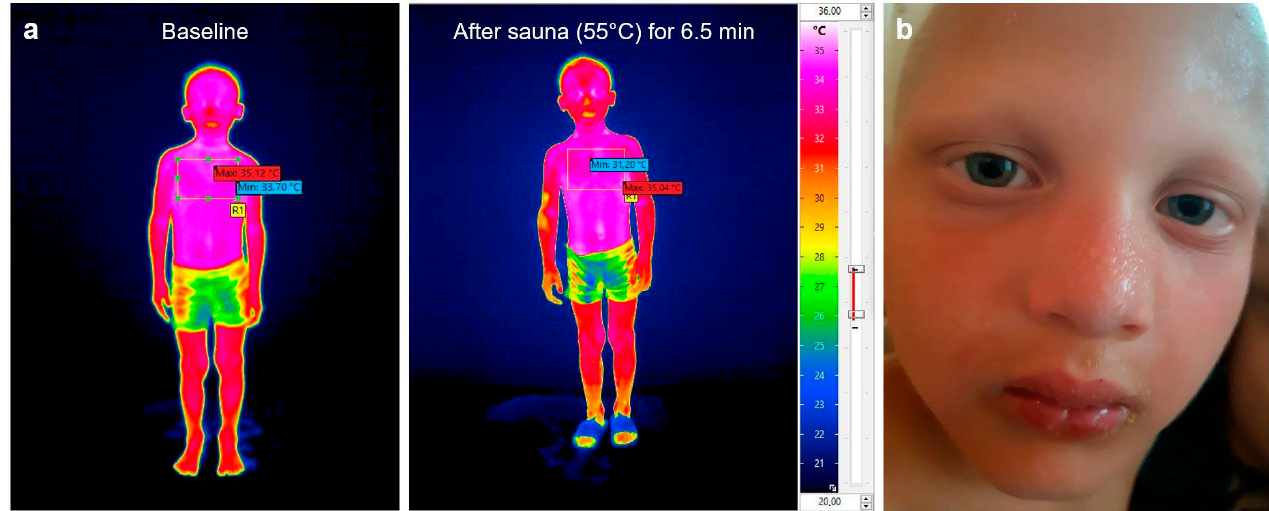
Figure 2. Documentation of thermal sweating. ( a ) Whole-body skin thermography of a 5-year-old prenatally treated XLHED patient (subject P1) before and after having a sauna. Efficient perspiration is indicated by skin temperatures lower than 32.5 °C (red to yellow color), for example at the nose, the right arm, both hands, and the lower legs. ( b ) Visible thermal sweating on the face of this patient when leaving the sauna: the nose and the forehead were particularly covered by beads of sweat.